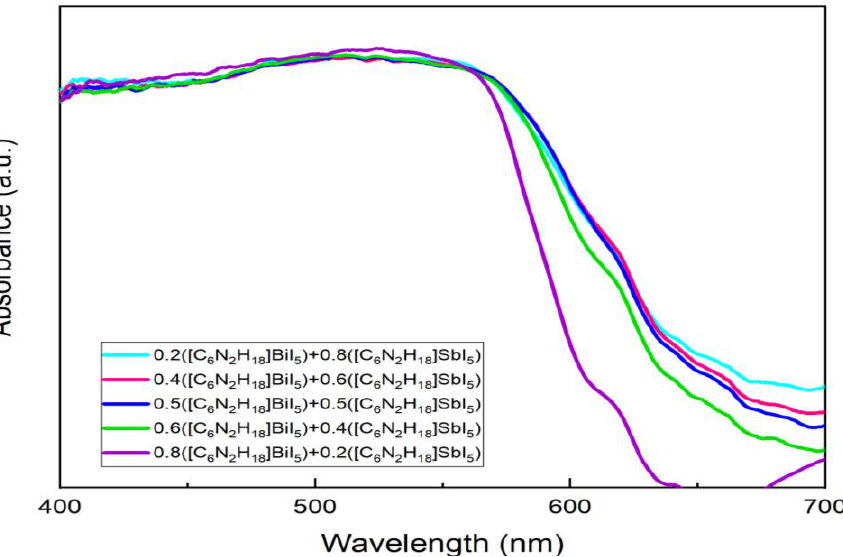
Figure 4. Ultraviolet/visible (UV/Vis) absorption spectra of multicomponent ferroelectric